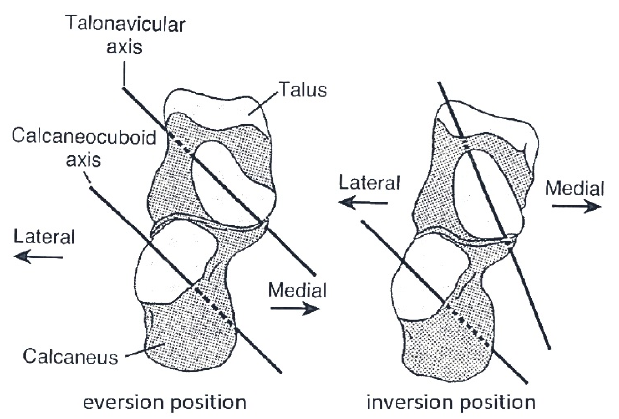
Figure 7. “Close-packed” (inversion) and “loose-packed” (eversion) positions of the midfoot. As the lower ankle joint inverts, the axes of the calcaneocuboid joint and talonavicular joint are convergent, thus locking the Chopart joint and providing rigidity to the midfoot in a “close-packed” position (the inversion position occurs from the standing phase to toe-off, as well as in a static standing position). When the lower ankle joint everts, the axes are parallel, and thus the midfoot is in a “loose-packed” position. Own elaboration based on a drawing from